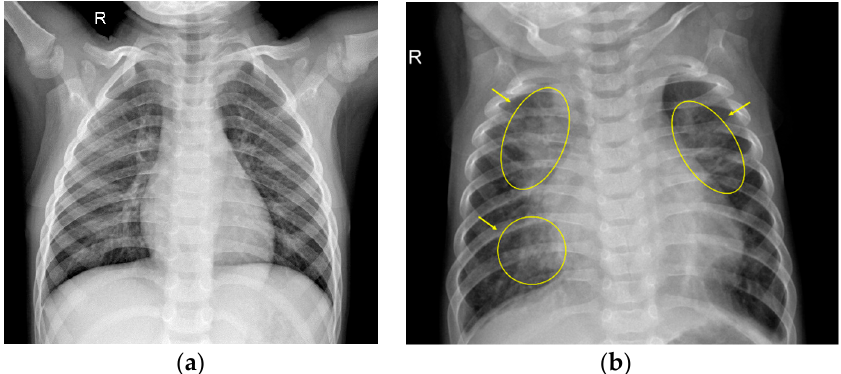
Figure 1. Example of images that the pneumonia dataset contains in which ( a ) is a normal chest X-ray images (CXRAY) image with no radiopaque segments; ( b ) shows a CXRAY image from a patient with pneumonia, in which radiopaque segments with consolidations caused by fluid accumulation are visible. Original images are from (https://data.mendeley.com/datasets/rscbjbr9sj/2), a publicly available dataset. Manual annotations were performed by us with the assistance of a doctor.